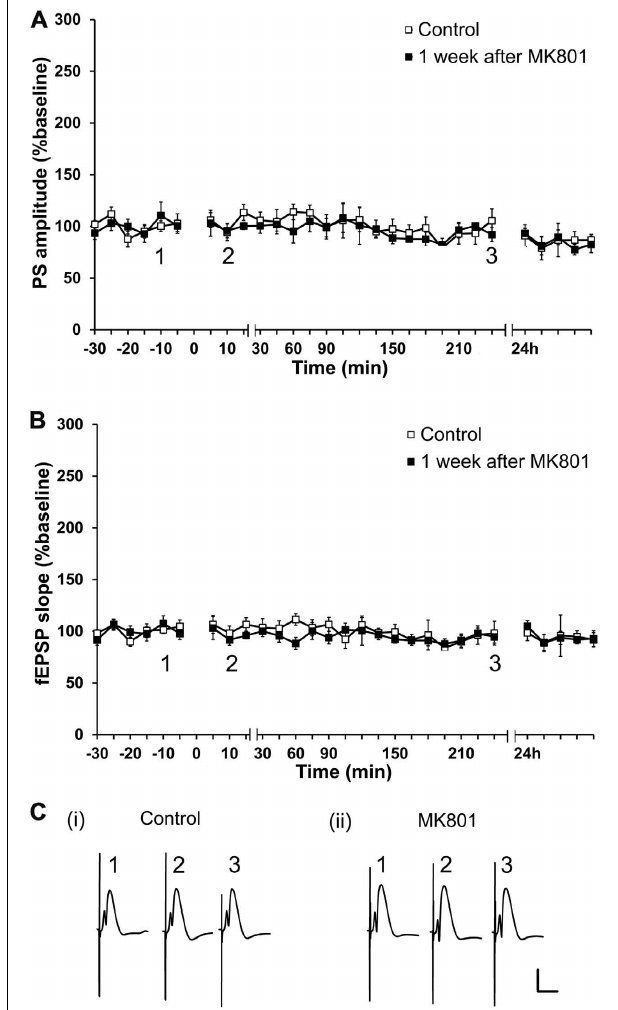
FIGURE 1 |Acute treatment with an irreversible NMDAR antagonist elicits no lasting effects on basal synaptic transmission. Basal synaptic transmission is unaffected 1 week after MK801-treatment. No differences in PS amplitude (A) or in fEPSP (B) occur 1 week after a single MK801-injection (black squares, n = 6) as compared to control baseline (white squares, n = 6) in response to test-pulse stimulation. Line breaks on the x -axis indicate change in time-scale. (C) Original analog traces show field potentials evoked from the dentate gyrus during (i) test-pulse stimulation before MK801-treatment and (ii) test-pulse stimulation 1 week after MK801-treatment.Vertical scale-bar corresponds to 5 mV, horizontal scale-bar to 10